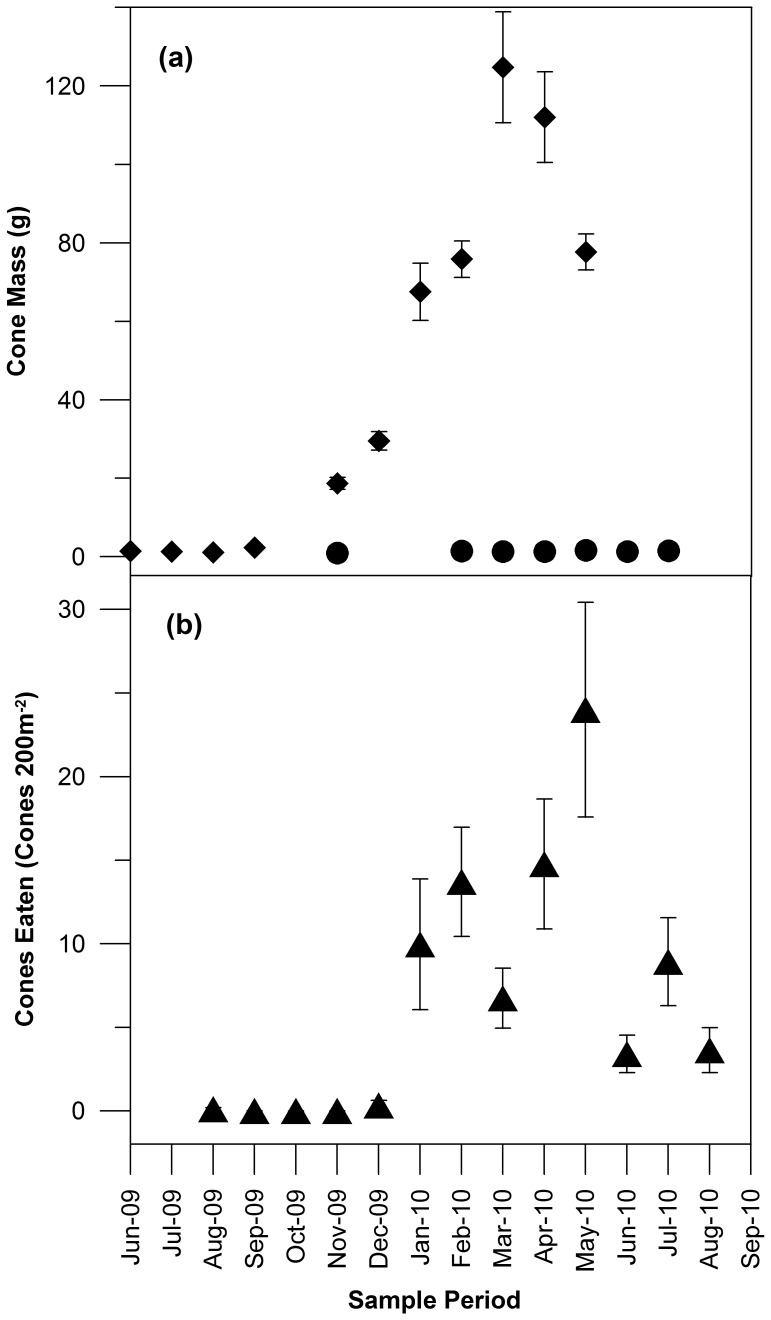
Seasonal growth (a) of two age cohorts of pine cones (pollinated in 2008 to mature in 2010–solid diamonds and pollinated in 2009 to mature in 2011–solid circles) and the seasonal use of pine cones (b) by Carnaby’s Cockatoos at 9 sites (mean±SE of 3 transects of 200 m−2 at each site) across the pine plantations of the Gnangara.